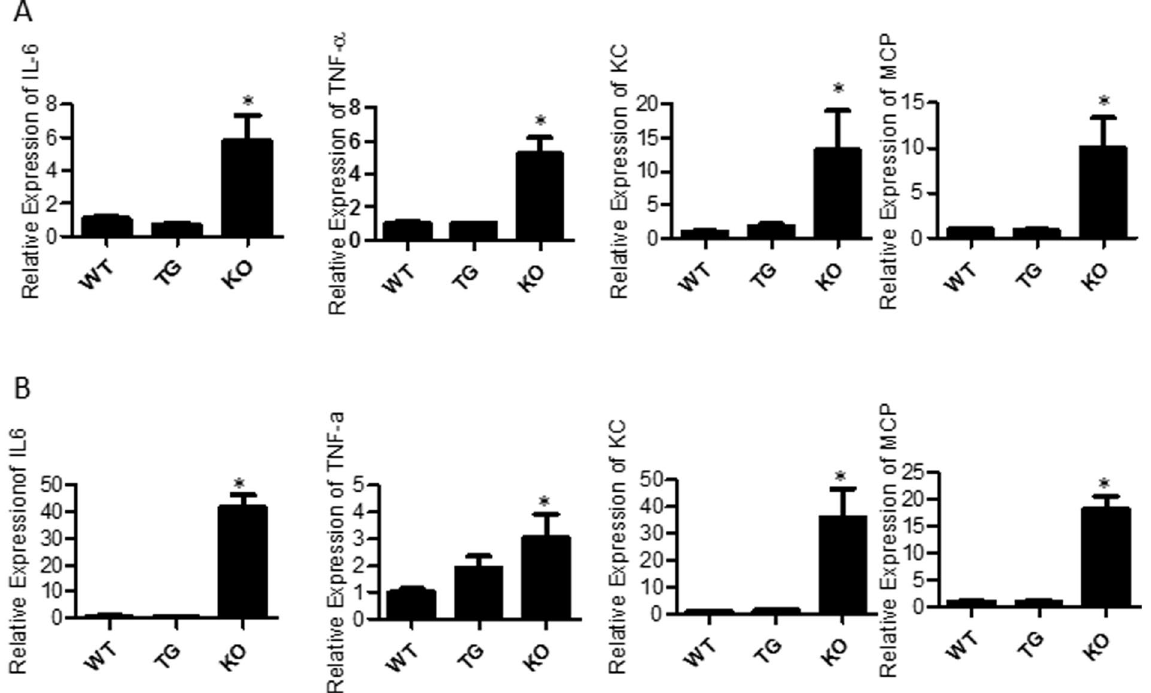
Figure 5. Inflammatory gene expression in kidney and heart tissue. WT, TG and KO mice were i.p injected with LPS. RNA was extracted from the cortex of the kidney and heart 16 h after LPS treatment. qRT-PCR was performed using SYBR green to detect the expression of IL-6, TNF- α , KC and MCP-1 and the housekeeping gene GAPDH was used as the internal control. Data is expressed using the ∆∆ CT method and normalized to WT + LPS. ( A ) Kidney tissues ( B ) Heart tissues. n = 3–5 = ; * P ≤